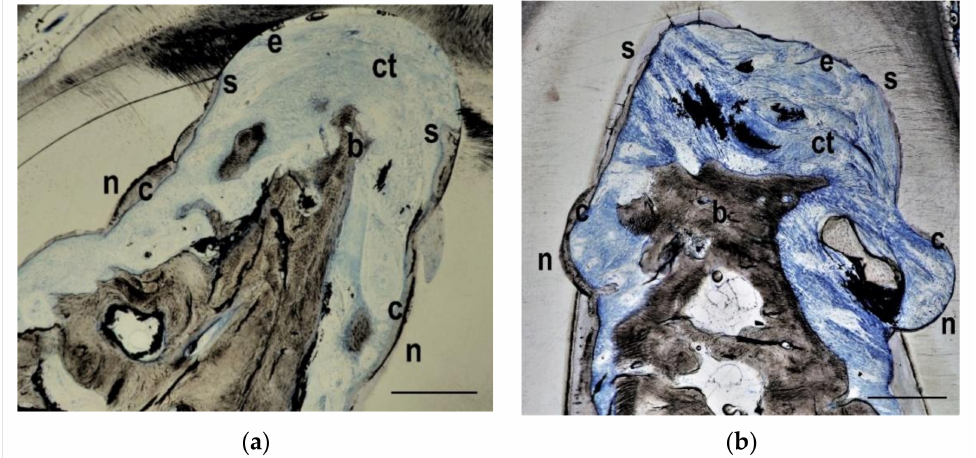
Figure 5. PDGF group histology from the keyhole ( a ) and the horizontal ( b ) defect types. Similar to the histologies of the GTR group, the notches (n) on both sides of the defect have been covered with a layer of new cementum (c), but the cement formation has stopped (s) coronal to the notches and has not covered the whole furcation roof. Again, some new bone ( b ) has grown into the furcation area and occupied approximately half of the defect height. Connective tissue (ct) and epithelium (e) have formed in the coronal part of the furcation. Bar in lower right corner represents 0.5 mm.